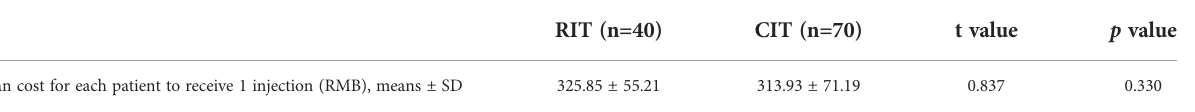
TABLE 7 Treatment cost for patients in the RIT and CIT groups.